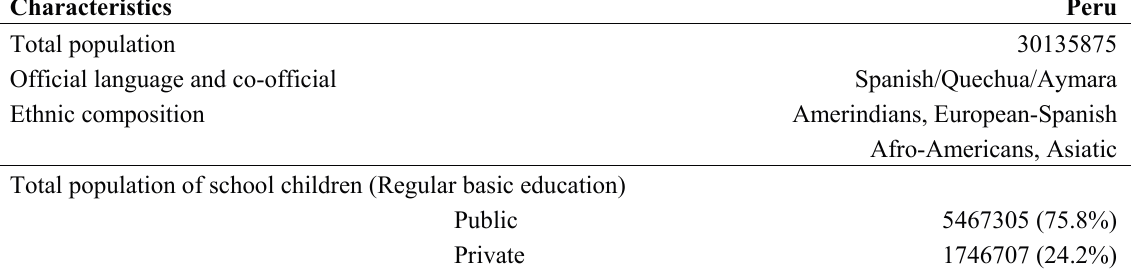
Table 1. Geographic, socioeconomic and educational characteristics of Peru. Characteristics